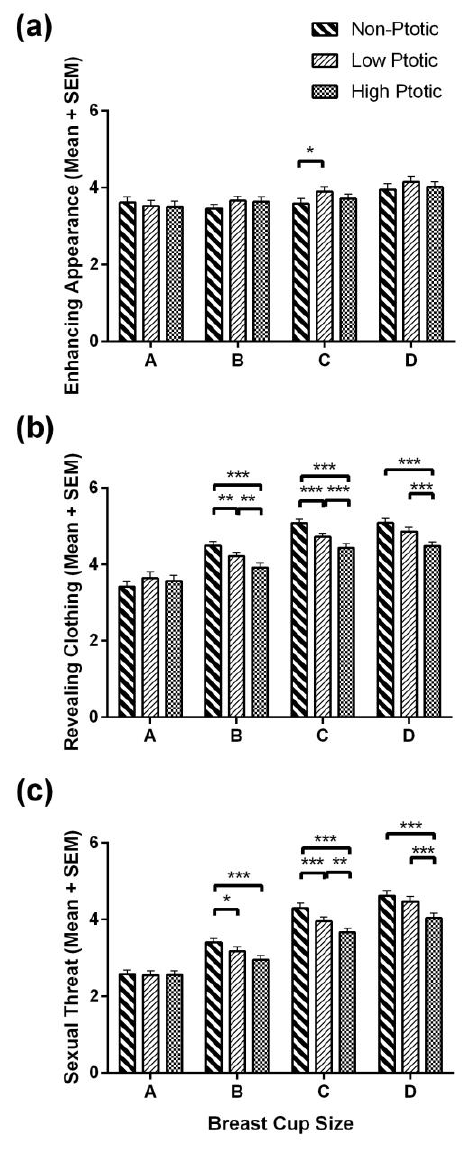
Figure 2. W omen’s likelihood of ( a ) enhancing their appearance, ( b ) wearing revealing clothing), ( c ) perceiving breasts as sexually threatening across breast sizes (A–D-cup) and levels of ptosis. Note: and ( c ) perceiving breasts as sexually threatening across breast sizes (A – D-cup) and levels of ptosis. p < 0.05 *, p < 0.01 **, p < 0.001 Note: p < 0.05 *, p < 0.01 **, p < 0.001 *** .